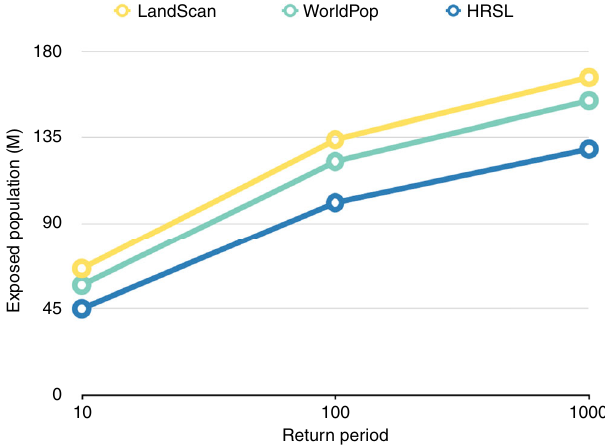
Fig. 3 Total exposed population. Total population exposed (millions) across all 18 countries, for the 1 in 10, 1 in 100, and 1 in 1000 year fl ood events